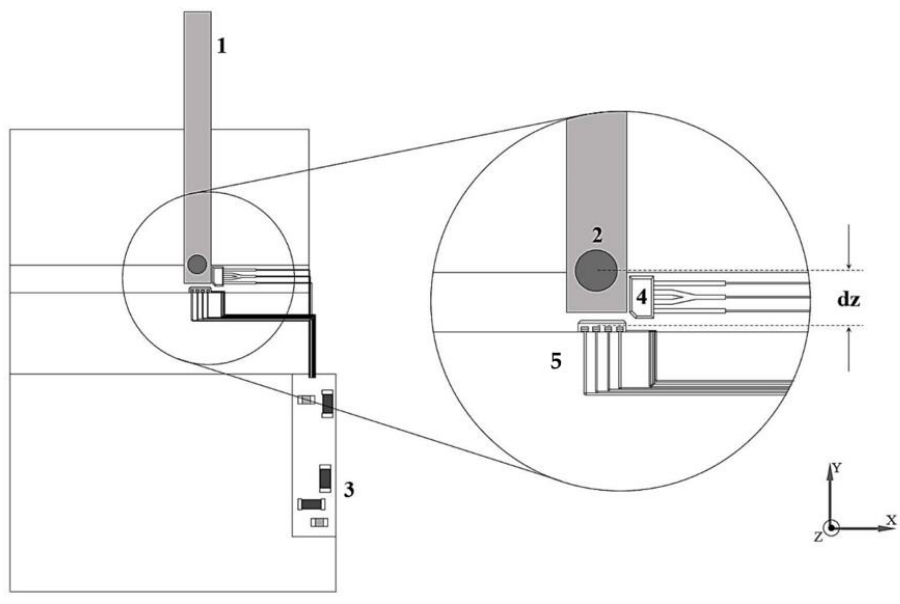
Figure 2. Acrylic plate (probe Hall) in the center with two Hall effect sensors, which have a maximum sensitivity of 110 mV/mT, due to the AD-AD22151 Hall effect sensor.